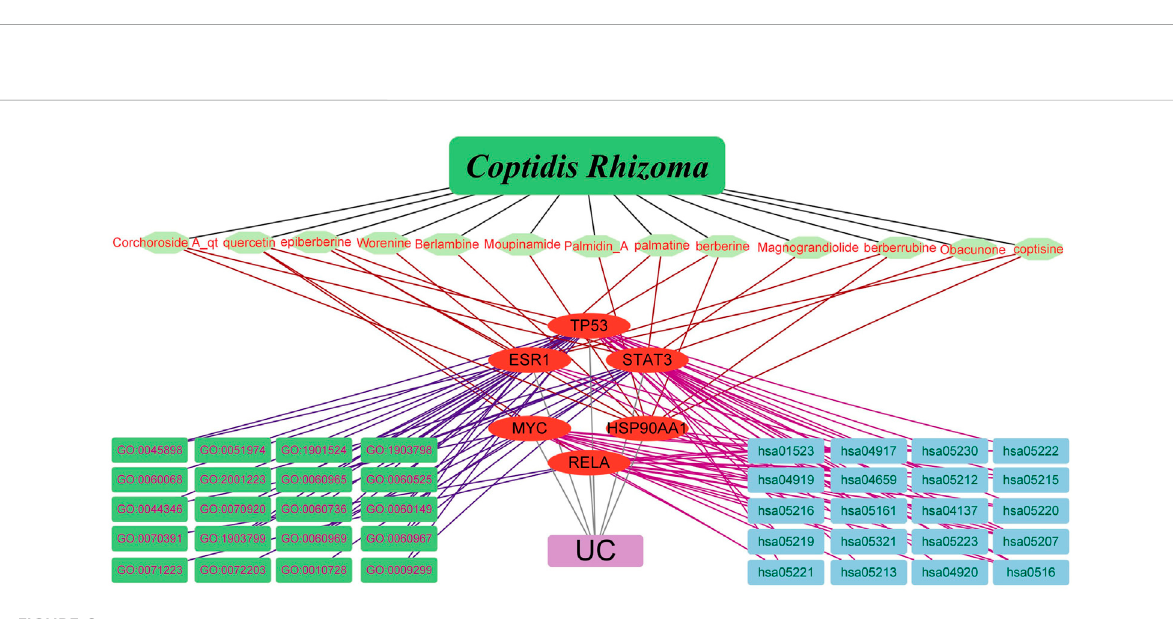
FIGURE 6 Network visualization from bioinformatics analysis highlighting the detailed interactions of